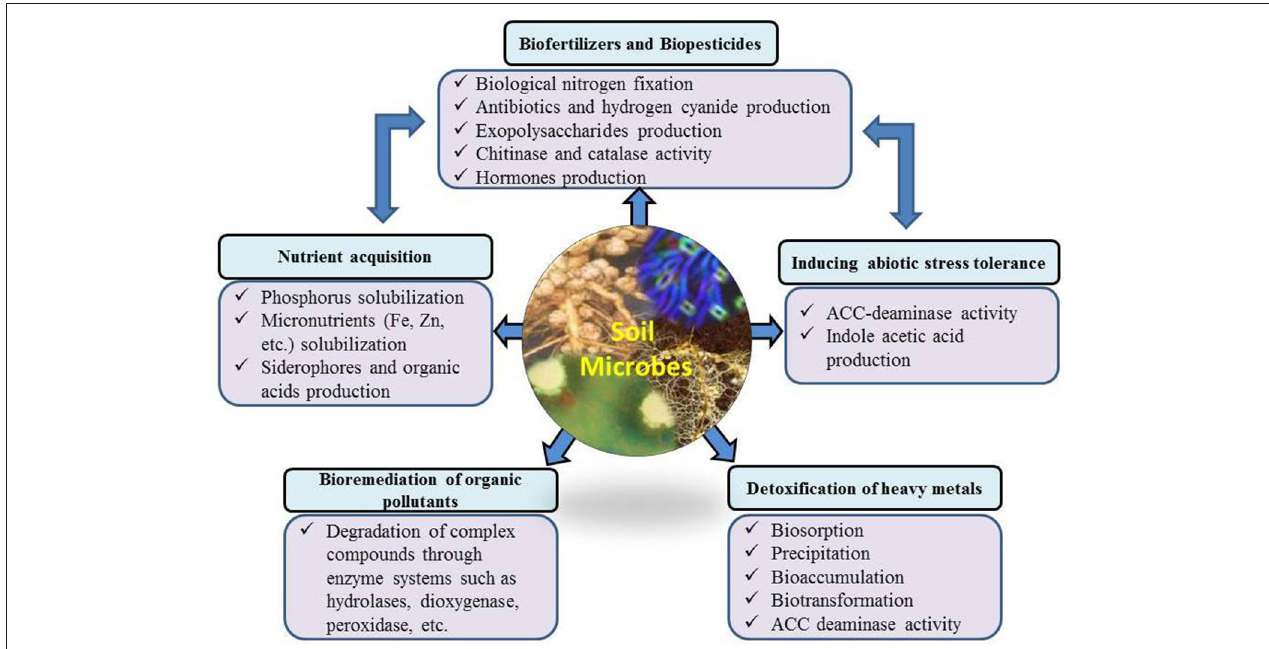
FIGURE 2 | Importance of the microbial community for environmental health and possible mechanisms of